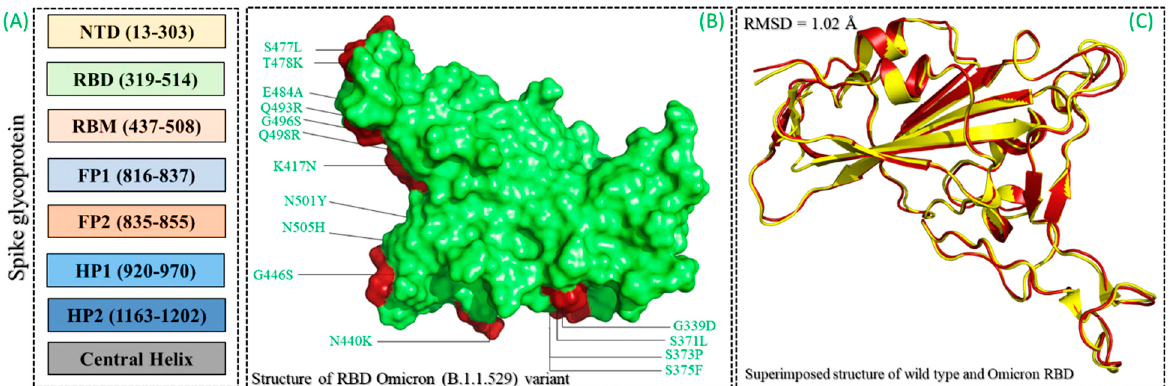
Figure 2. ( A ) Domains organization of spike glycoprotein. ( B ) Structure of reception-binding domain (RBD) and mutations mapping reported in the Omicron variant (B.1.1.529). ( C ) Superimposed structures of the wild-type and B.1.1.529 RBDs.